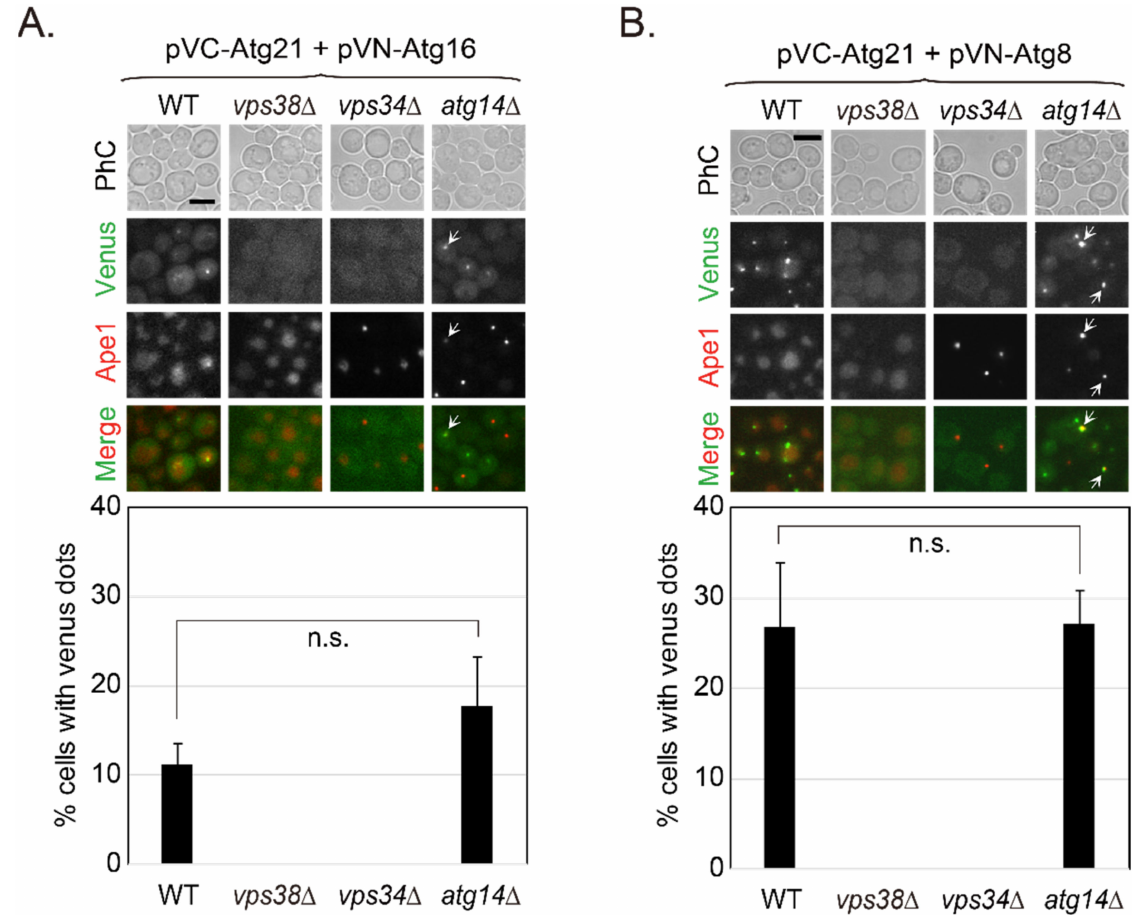
Figure 6. Atg21-Atg16 and Atg21-Atg8 interactions are dependent on PI3K complex II. ( A ) The Atg21-Atg16 interaction depended on Vps38 and Vps34 but not on Atg14. ( B ) The Atg21-Atg8 interaction depended on Vps38 and Vps34 but not on Atg14. The interactions were determined in BiFC assays using the indicated strains expressing RFP-Ape1 and BiFC plasmids. Arrows indicate the colocalization between Venus and Ape1 dots. The percentages of cells with Venus-positive dots were quantified and are shown below the merge pictures. Scale bars, 5 µ m. n.s., not